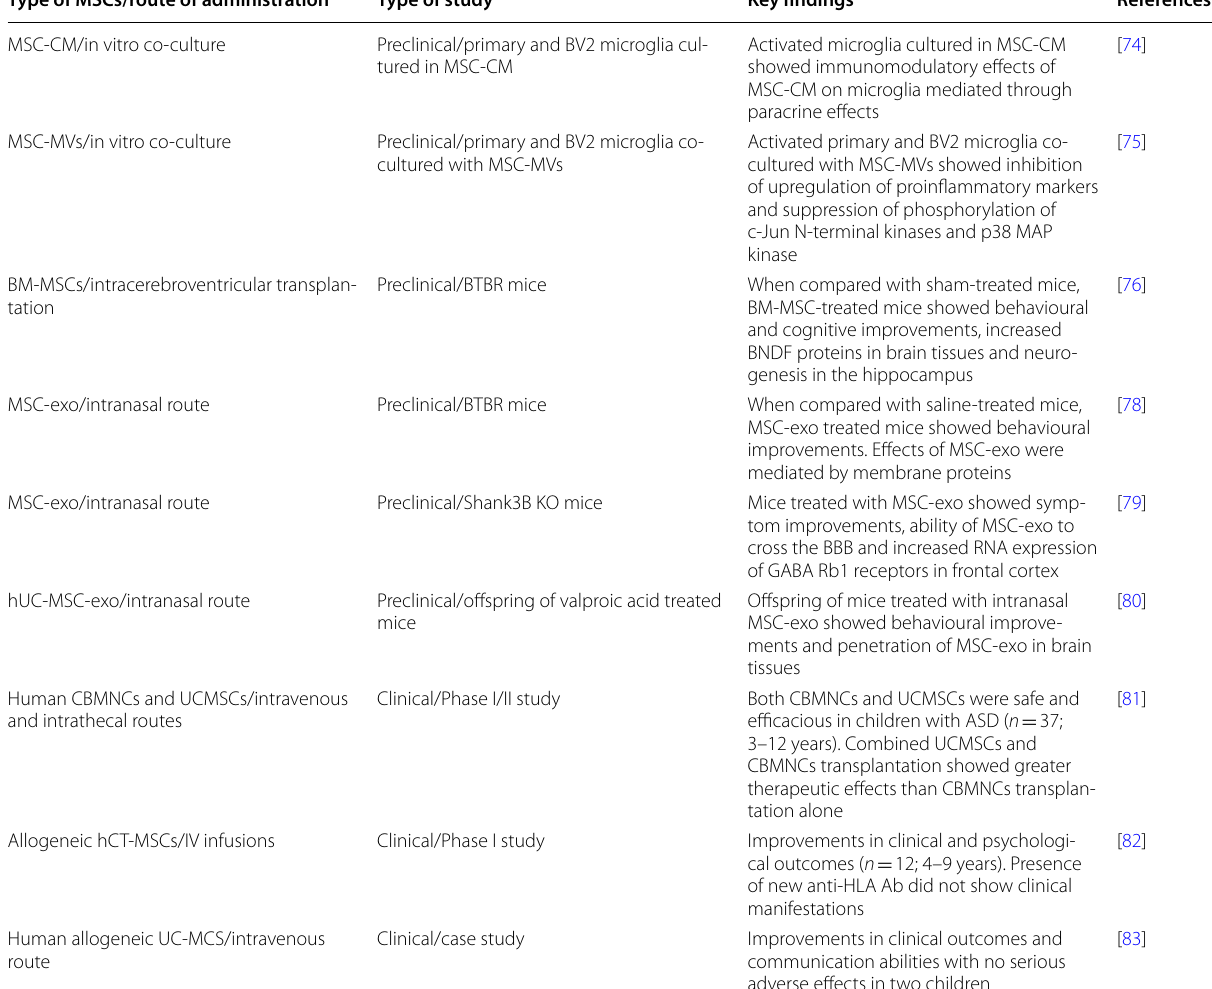
Table 2 Summary of applications of MSCs in